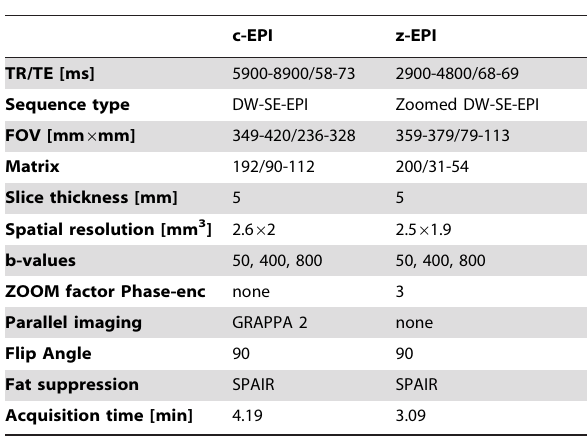
Table 1. Imaging parameters. Table 2. Individual ADC values ( 6 10 2 3 s/mm 2 ) for the 23 patients for both sequences.